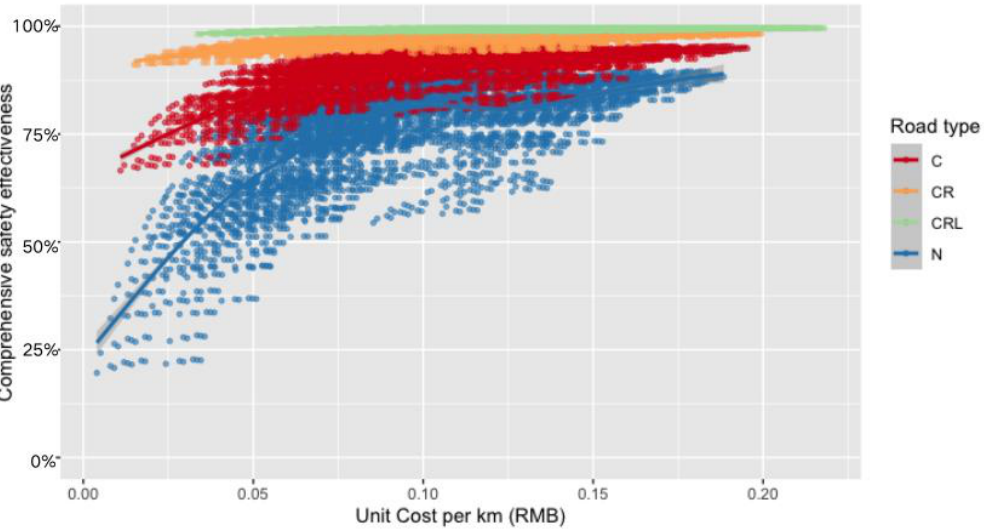
Figure 7. Map of comprehensive collision avoidance effectiveness and life-cycle shared cost of “atomic” technology combinations (unit cost per km).